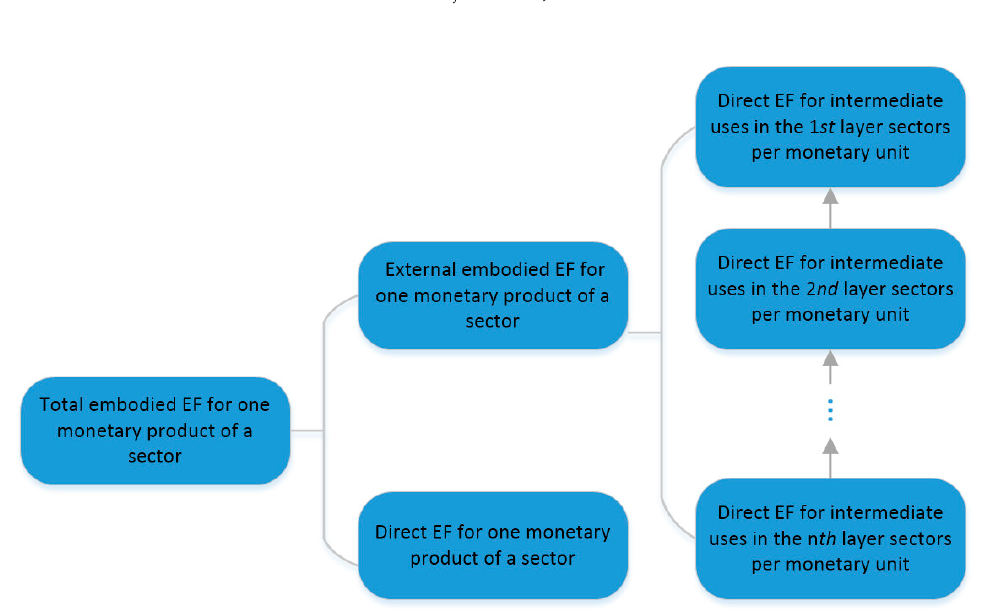
Figure 3. Decomposition of a sector’s EFPI.